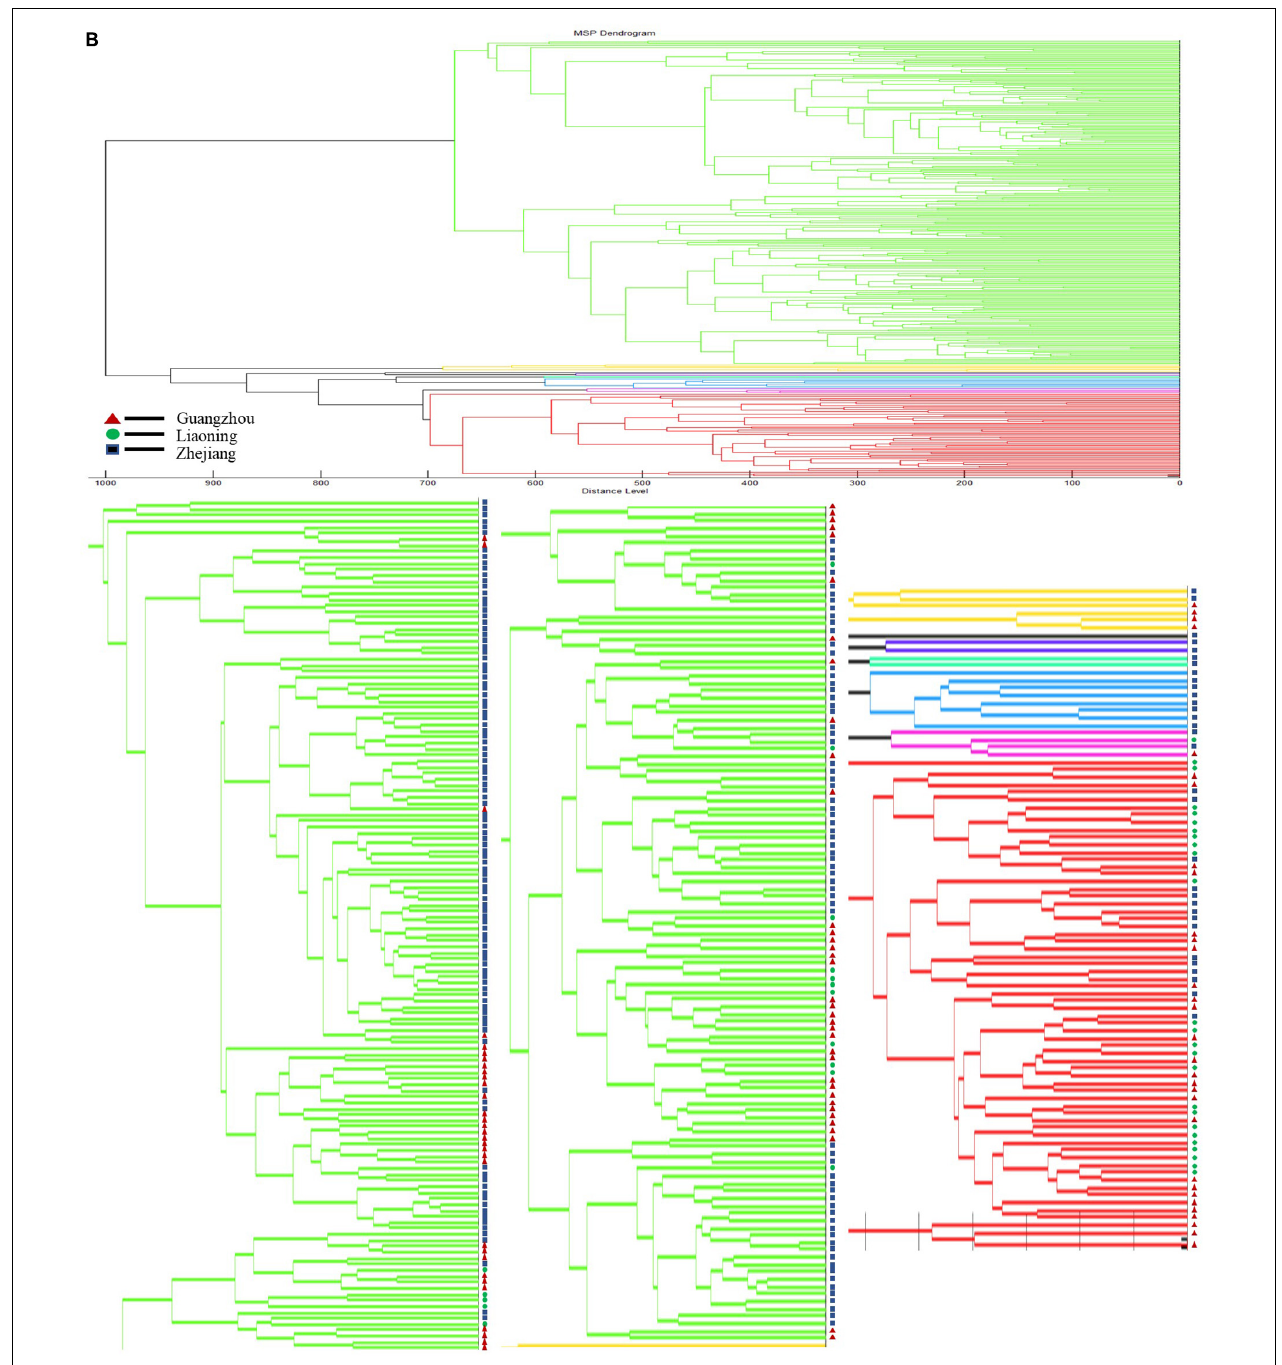
FIGURE 8 | Dendrogram analysis of clinical strains and environmental strains. (A) Dendrogram analysis of V. vulnificus . (B) Dendrogram analysis of V. parahaemolyticus